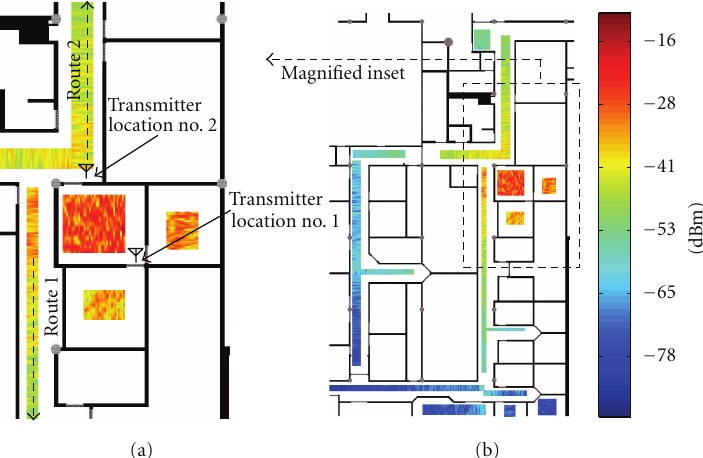
Figure 5: (b) Blueprint of the basement of the ECE bulding. at UNM where channel measurements are collected—a colormap of the measured received signal power is superimposed on the map for the transmitter at location #1. (a) A magnified inset of the blueprint.